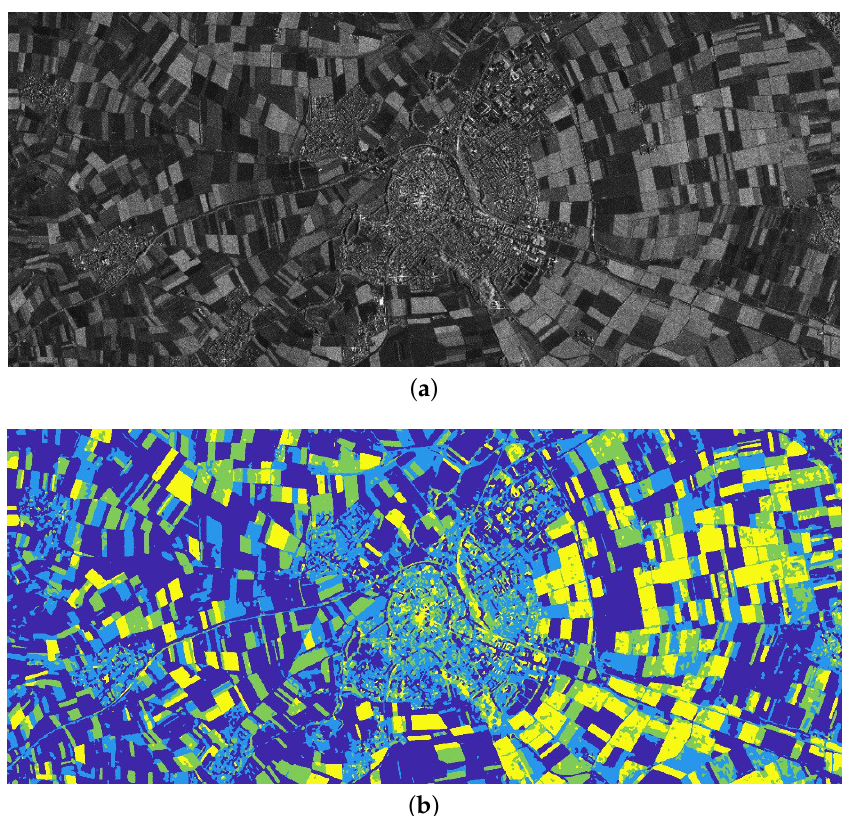
Figure 19. Segmentation results on a large data set: ( a ) original image; ( b ) segmentation